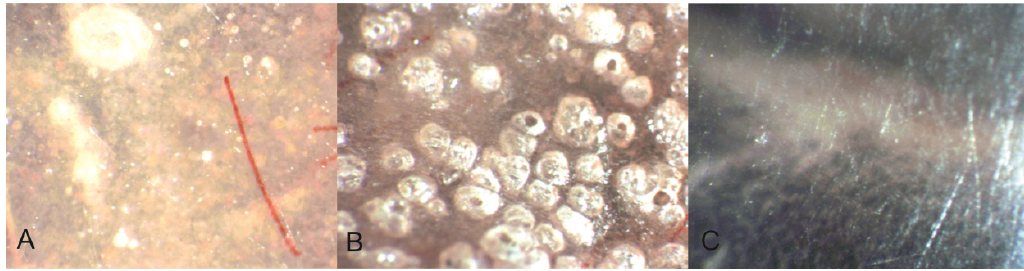
Figure 7. Different polymers have a different density and surface structure. The amount and size of pores and surface defects will affect the biofilm formation and composition. ( A ) polished heat cured acrylic; ( B ) unpolished cold cured acrylic; ( C ) polished polyamide (photo: Marit